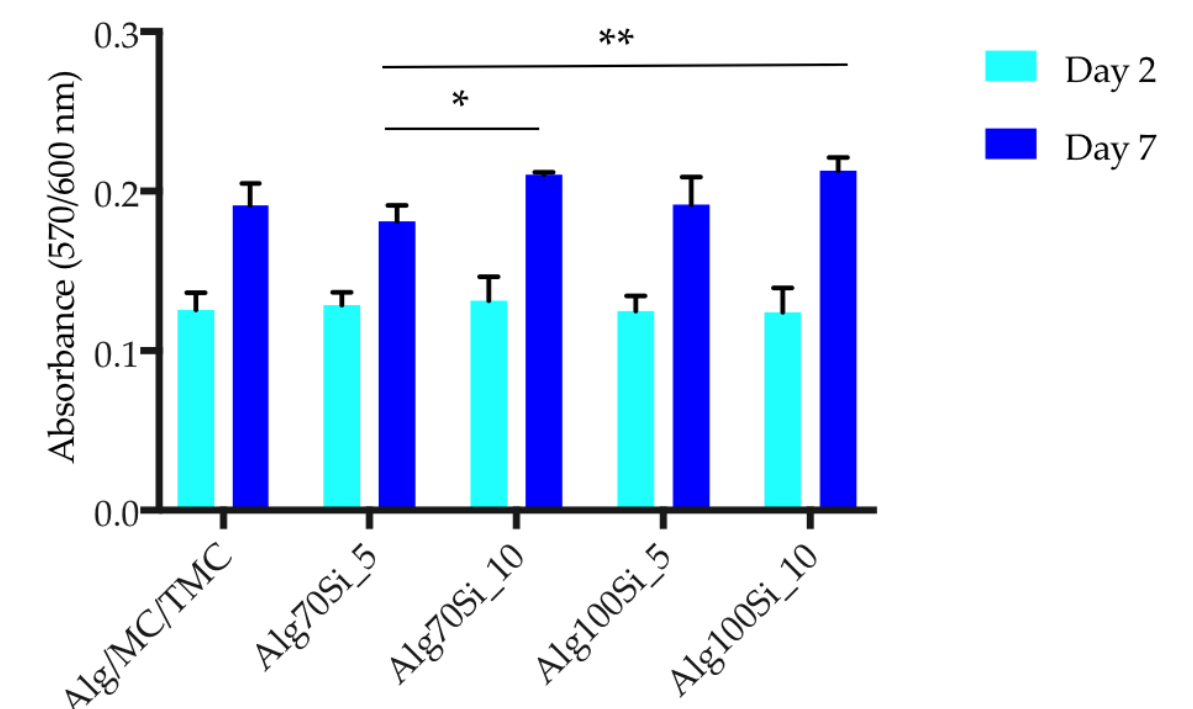
Figure 7. Cytotoxicity assessment of the five scaffold compositions. Cell metabolic activity of MC3T3-E1 pre-osteoblasts is expressed as absorbance units. The values represent means ± standard deviations of triplicates ( n = 3), and the asterisks indicate statistical significance compared to the Alg/MC/TMC control surface at each experimental time point (*: p < 0.05, **: p < 0.01).